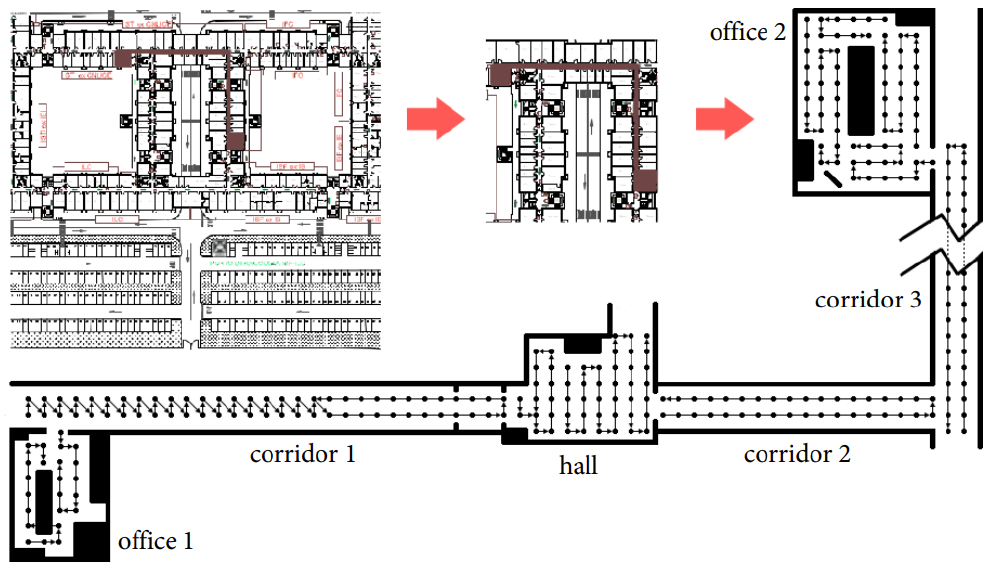
Figure 14. Map and trajectory of the path used for the data collection in